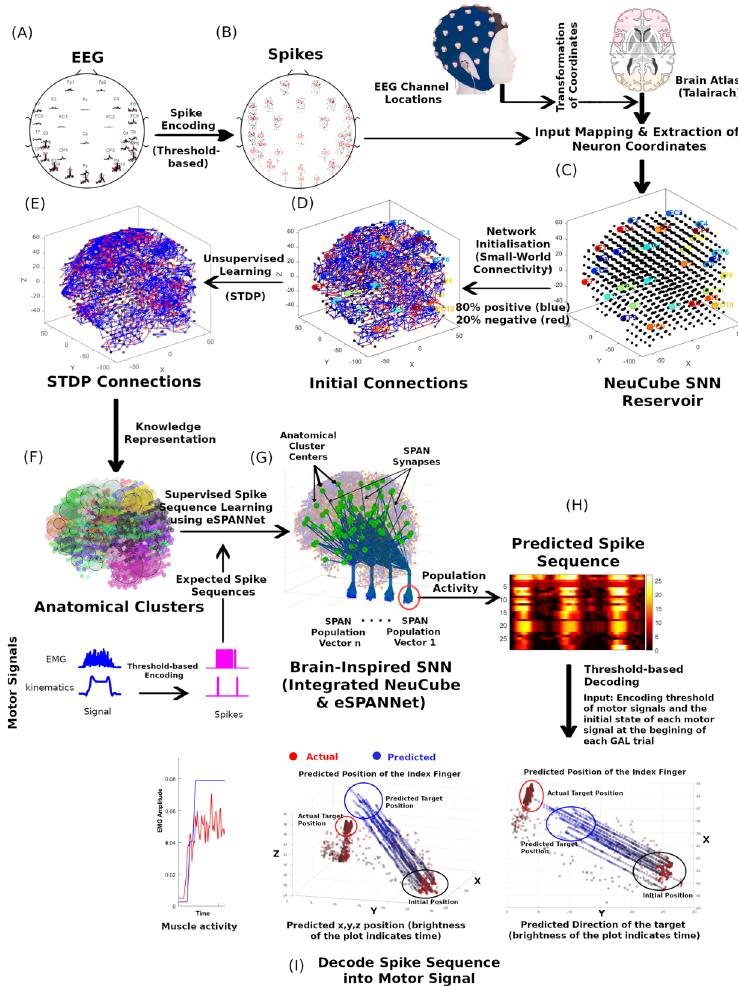
Figure 1. Integration of the eSPANNet with the NeuCube SNN architecture and major steps in training a BI-SNN model—( A ) filtered EEG, ( B ) spike encoding, ( C ) extraction of brain coordinates from a brain template and mapping EEG channel locations, ( D ) initialisation of the SNN based on the small-world connectivity principle, ( E ) unsupervised spike time dependent plasticity learning, ( F ) extraction of anatomical clusters, ( G ) training population vectors using eSPANNet learning, ( H ) predicted spike sequence by the SNN, ( I ) decoding predicted spike sequences into muscle activity and kinematics using the threshold-based